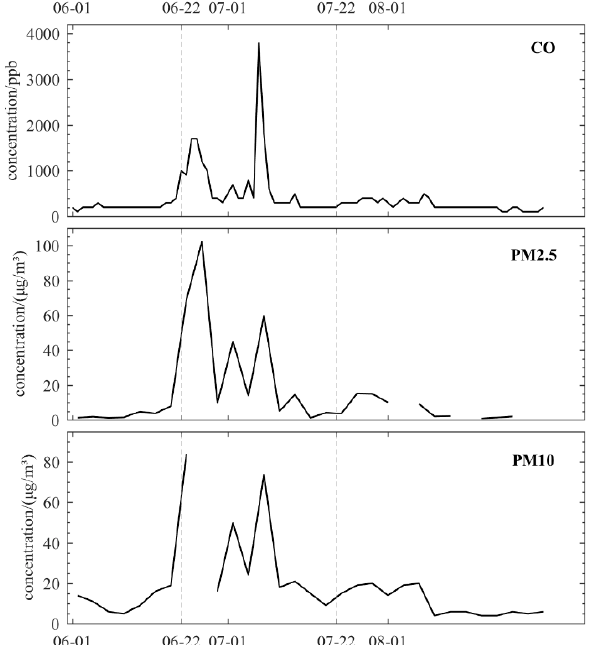
Figure 6. Variations of CO, PM 2.5 , and PM 10 concentrations in Fairbanks during summer 2015. The first gray dashed line marks the start date of the Aggie Creek Fire. The region between the two gray dashed lines is the approximate lasting period of the fire. CO was sampled daily within the period. PM 2.5 and PM 10 were sampled every three days within the period.